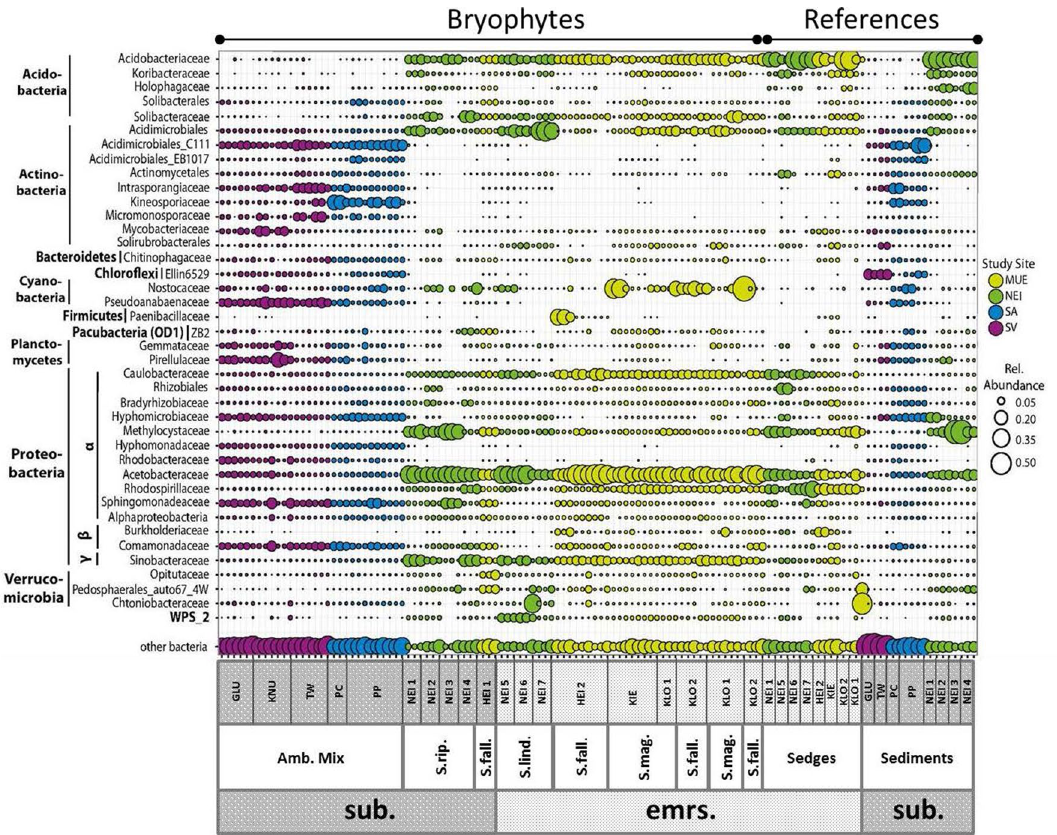
Figure 5. Overview of the relative abundances of bacterial families making up more than 0.5% of the total bacterial sequences in one or more 16S rRNA gene libraries. The sizes of the circles correspond to the relative abundances of the families. The colors indicate which region the samples originate from. MUE: Mueritz, Northern Germany (light green); NEI Neiden, Northern Norway (dark green); SA Samoylov, Russia (blue); SV Svalbard, Norway (violet). The samples are sorted by ecosystem types and latitude from left to right. sub. = submerged. emrs. = emerged/above the water table. Amb. Mix. = a mix of Amblystegiaceae . S. rip. = Sphagnum riparium . S. fall. = Sphagnum fallax. S. mag = Sphagnum magellanicum . S. Lind. = Sphagnum lindbergii